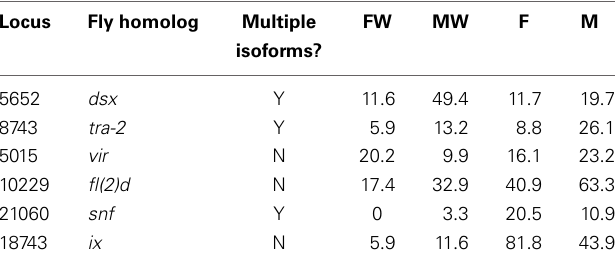
in determining early Sxl splicing pattern. The genes for which Z. pullula homologs have been identified in this study, are boxed in gray. For more details on the regulation and function of these genes, refer to (Sánchez, 2008; Gempe and Beye, 2011) or other similar resources. Reproduced with permission from The International Journal of Developmental Biology (Int. J. Dev. Biol.) (2008) Vol:52, pp.